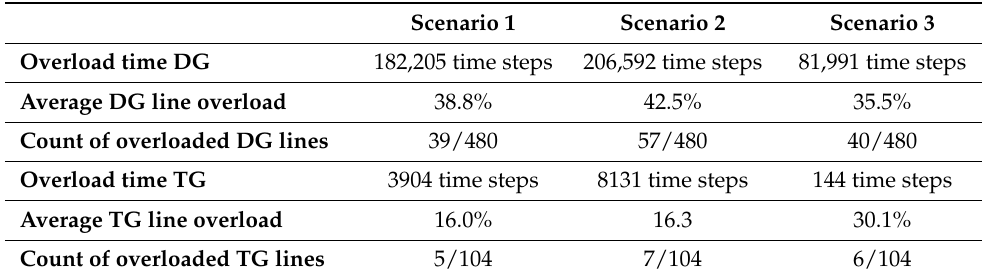
Table 5. Comparison of scenario